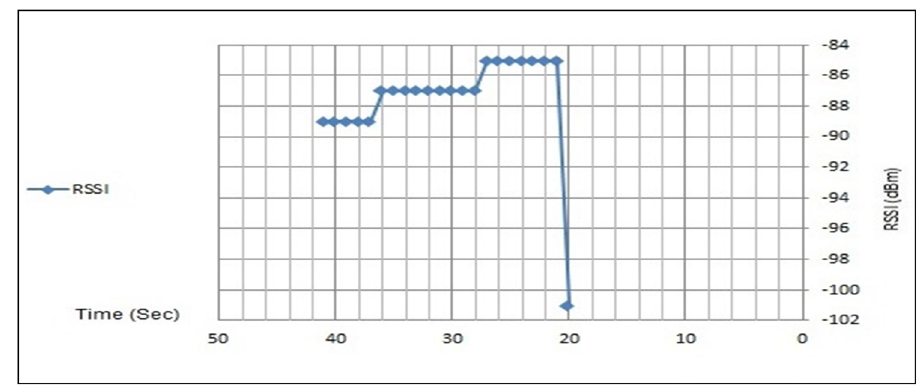
Figure 6: RSSI value when reconnection with network